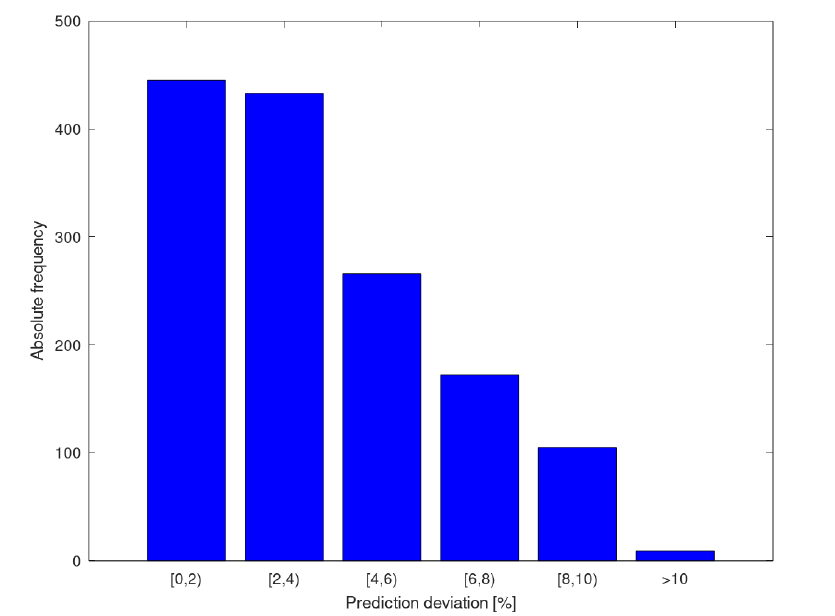
Figure 8. Histogram of the prediction error of the yield strength for all